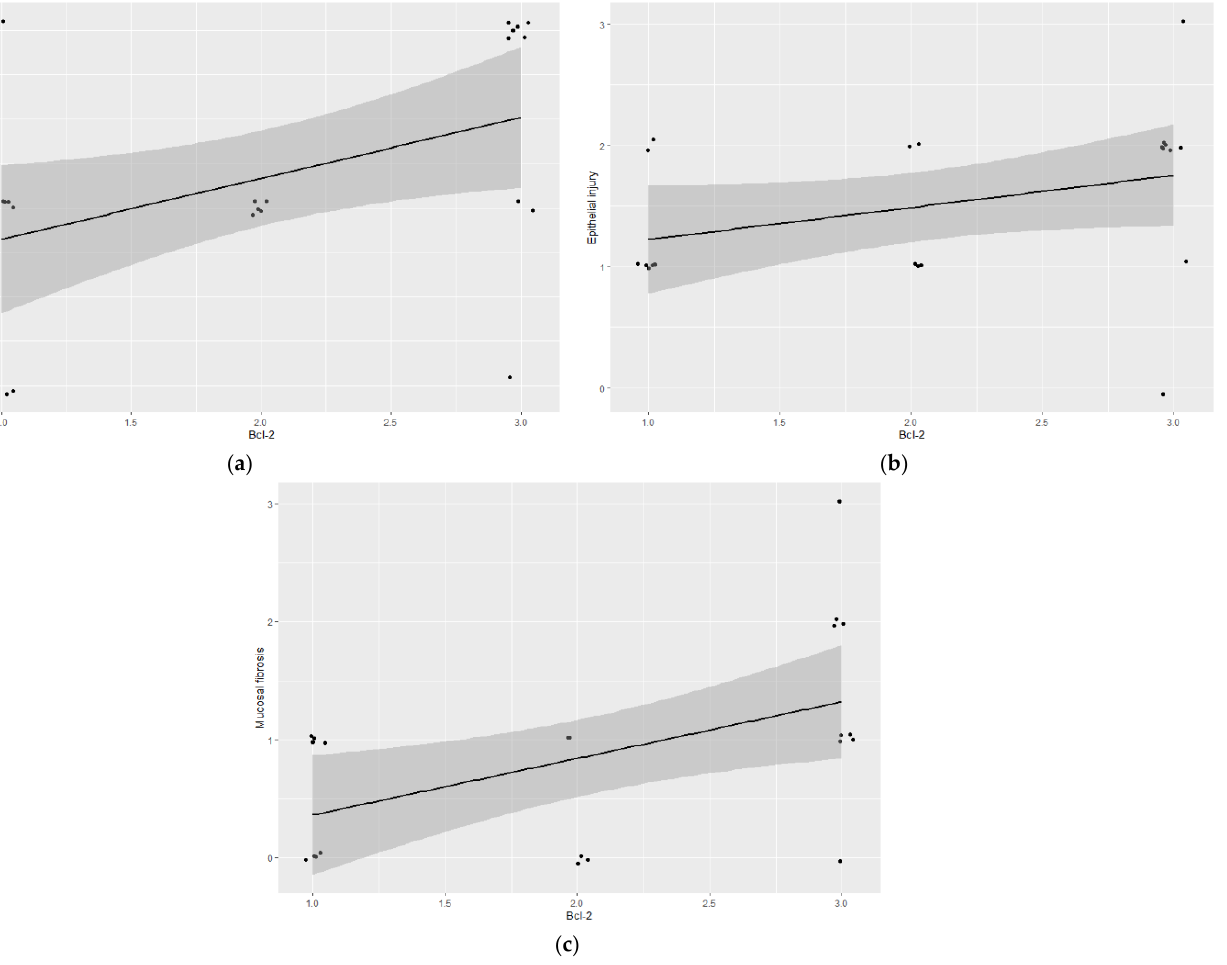
Figure 2. Feline epitheliotropic duodenal T-cell lymphoma: Plots of Spearman’s correlation coeffi- cients between Bcl-2 and ( a ) villous stunting, ( b ) epithelial injury, and ( c ) mucosal desmoplasia.